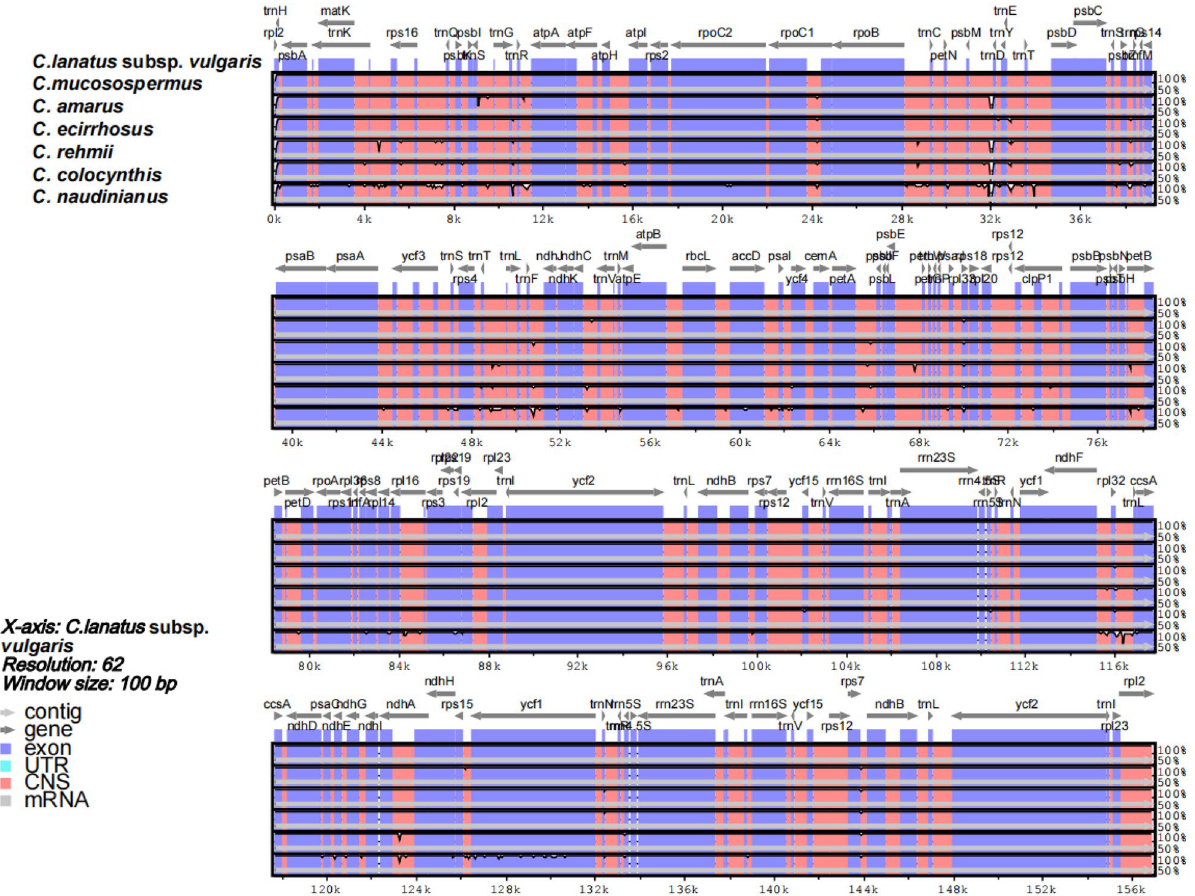
Figure 2. Structure comparison of seven CPGs using mVISTA